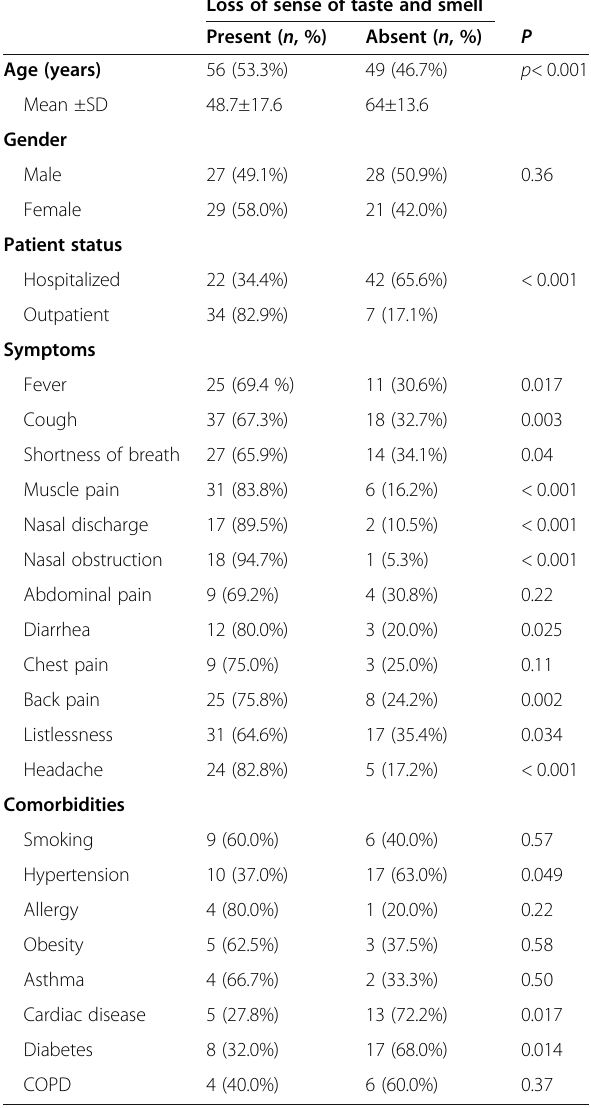
Table 1 The demographic and clinical characteristics of patients according to smell and taste dysfunction